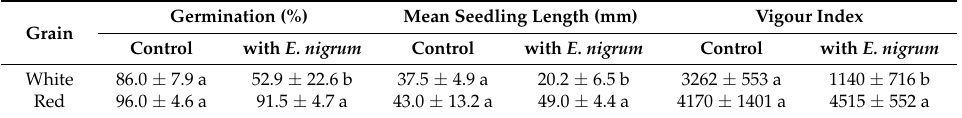
Table 1. Rice germination and vigour after incubation at 10 ◦ C for 14–17 days and then at 30 ◦ C for three days. Values for white and red grain types are averages ( ± standard deviation among genotype means) of the three white-grained cultivars and of the three red-grained varieties, respectively. For every parameter (germination, mean seedling length, and vigour index), nested ANOVA showed a significant effect ( p < 0.05; n = 15–24 data for cell mean) of both grain type (red/white), treatment (presence/absence of Epicoccum nigrum inoculum) and their interaction. For each parameter, values with the same letter are not significantly different ( p ≤ 0.05; Tukey’s test; n = 15–24 data for cell